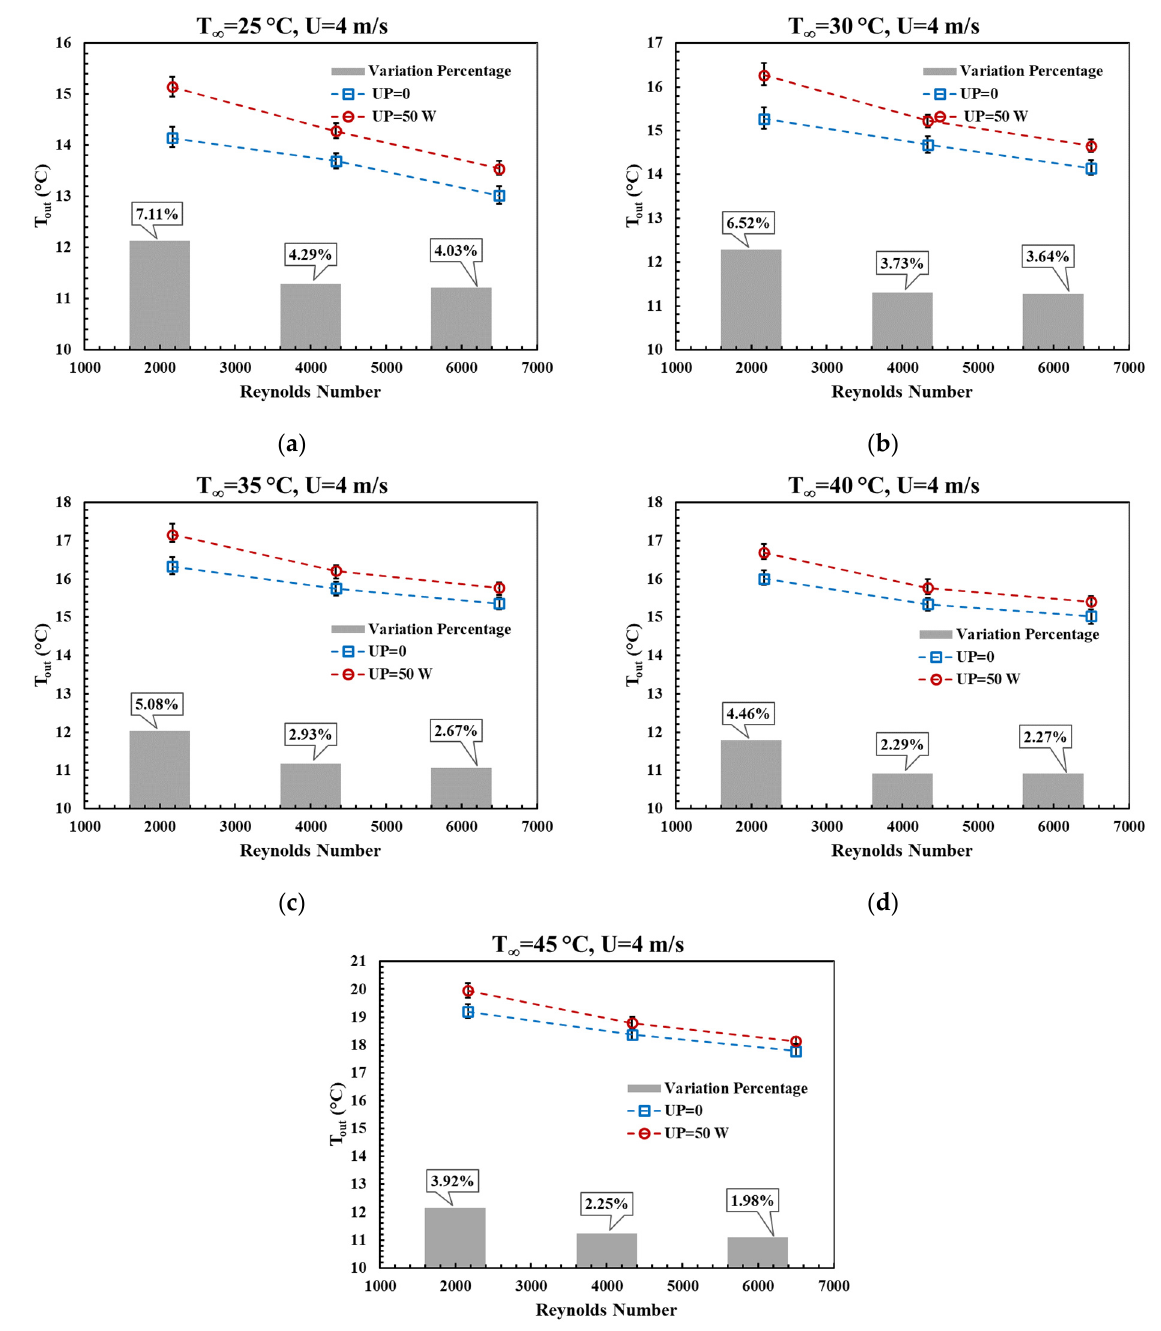
Figure 6. Variation of outlet temperature versus Re number at U = 4 (m/s) and ( a ) T ∞ = 25 ( ◦ C), ( b ) T ∞ = 30 ( ◦ C), ( c ) T ∞ = 35 ( ◦ C), ( d ) T ∞ = 40 ( ◦ C), and ( e ) T ∞ = 45 ( ◦ C) . The results are presented in a no-vibration state (UP=0) and in the presence of vibration with ultrasonic power of 50 Watts (UP = 50 (W)).